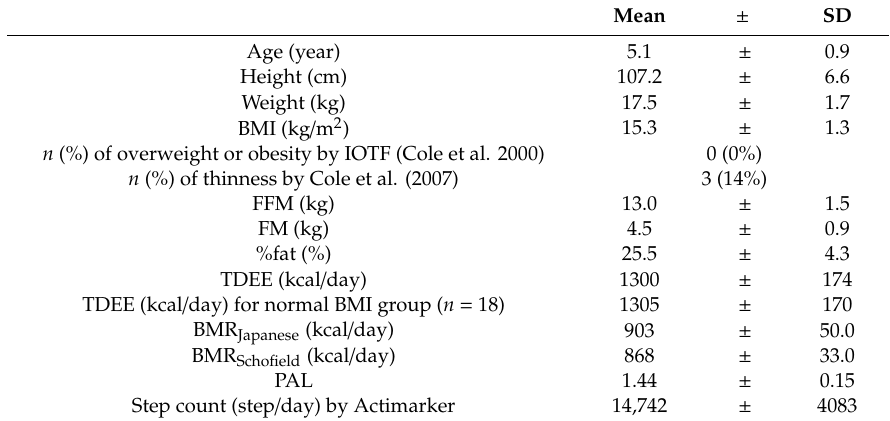
Table 1. Physical characteristics, body composition, energy expenditure, and daily step counts of the participants ( n = 21).